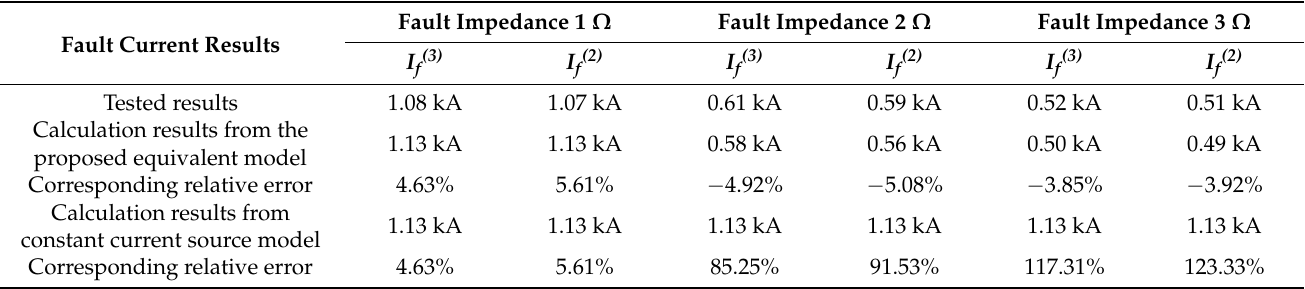
Table 3. Tested simulation and calculated theoretical results of fault current provided by PV station after the fault f 2